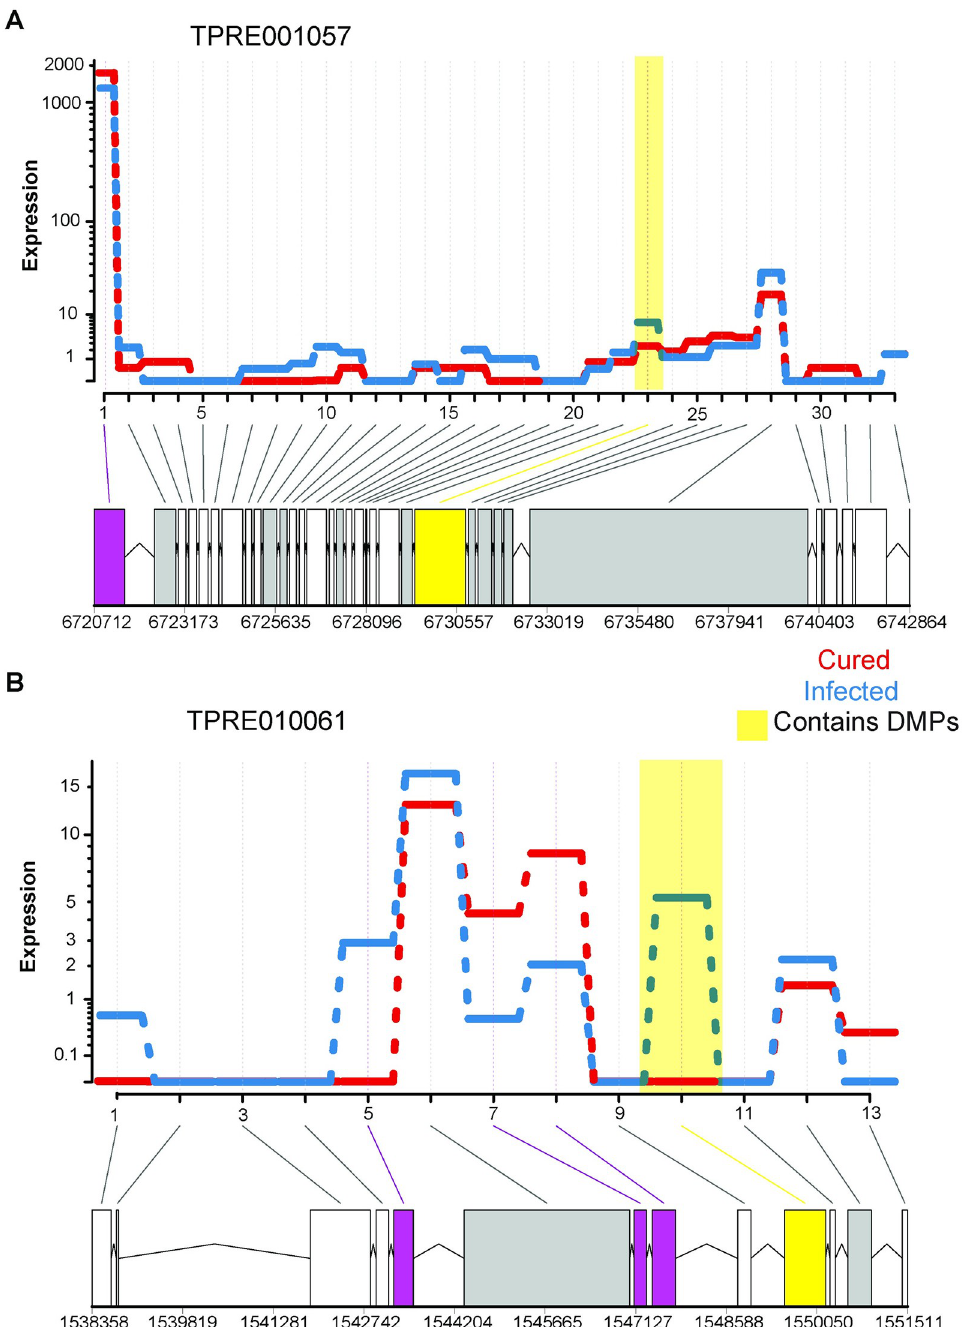
Fig 4. Representative genes showing differential exon usage between cured and infected Trichogramma . Boxes filled in purple are differentially used exons. Among the differentially used exons, those that contain DMPs are shown in yellow-filled boxes. A) Gene TPRE001057, ortholog of D . melanogaster CG14299 , contains 2 differentially used exons, exons 1 and 23 (exon numbers are shown as integers on the x-axis). The exon 23 contains 6 DMPs is highlighted with a yellow-filled box. B) Gene TPRE010061, ortholog of D . melanogaster Mzt1 , contains 4 differentially used exons (exons 5, 7, 8, and 10). The exon 10 has 8 DMPs and shown in yellow-filled box.